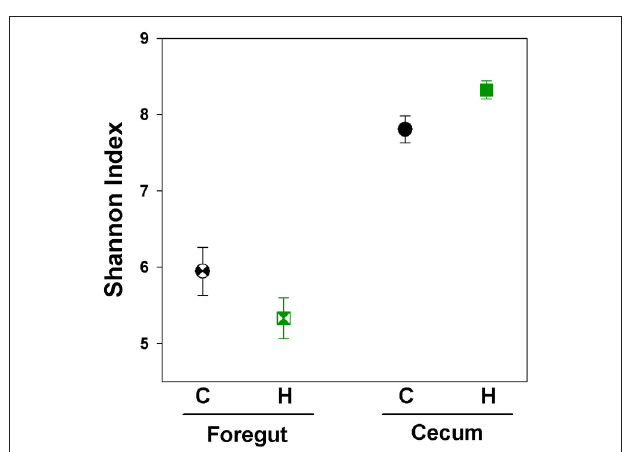
FIGURE 4 | Shannon index of microbial communities of voles selected for different traits. Points represent mean ± SEM . C, Control; H, Herbivorous. The foregut chamber harbored lower microbial diversity than the cecal chamber. No difference in diversity was observed between the foregut communities of Control and Herbivorous-selected voles. Cecal communities of Herbivorous-selected lines were significantly more diverse than Control lines. The points for cecal samples represent the same samples as presented in Figure 2 , except here we used a lower number of sequences per sample for analysis, due to a slightly lower return of sequences from some foregut